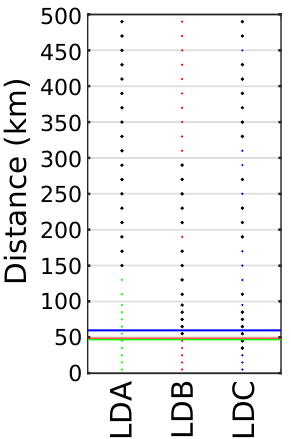
Figure 12. TSG Z -score over distance for LDA (left, green), LDB (center, red), and LDC (right, blue). | Z | > 2 is shaded black. Rossby radii R D distance plotted in horizontal dashed lines, color coded to the LD